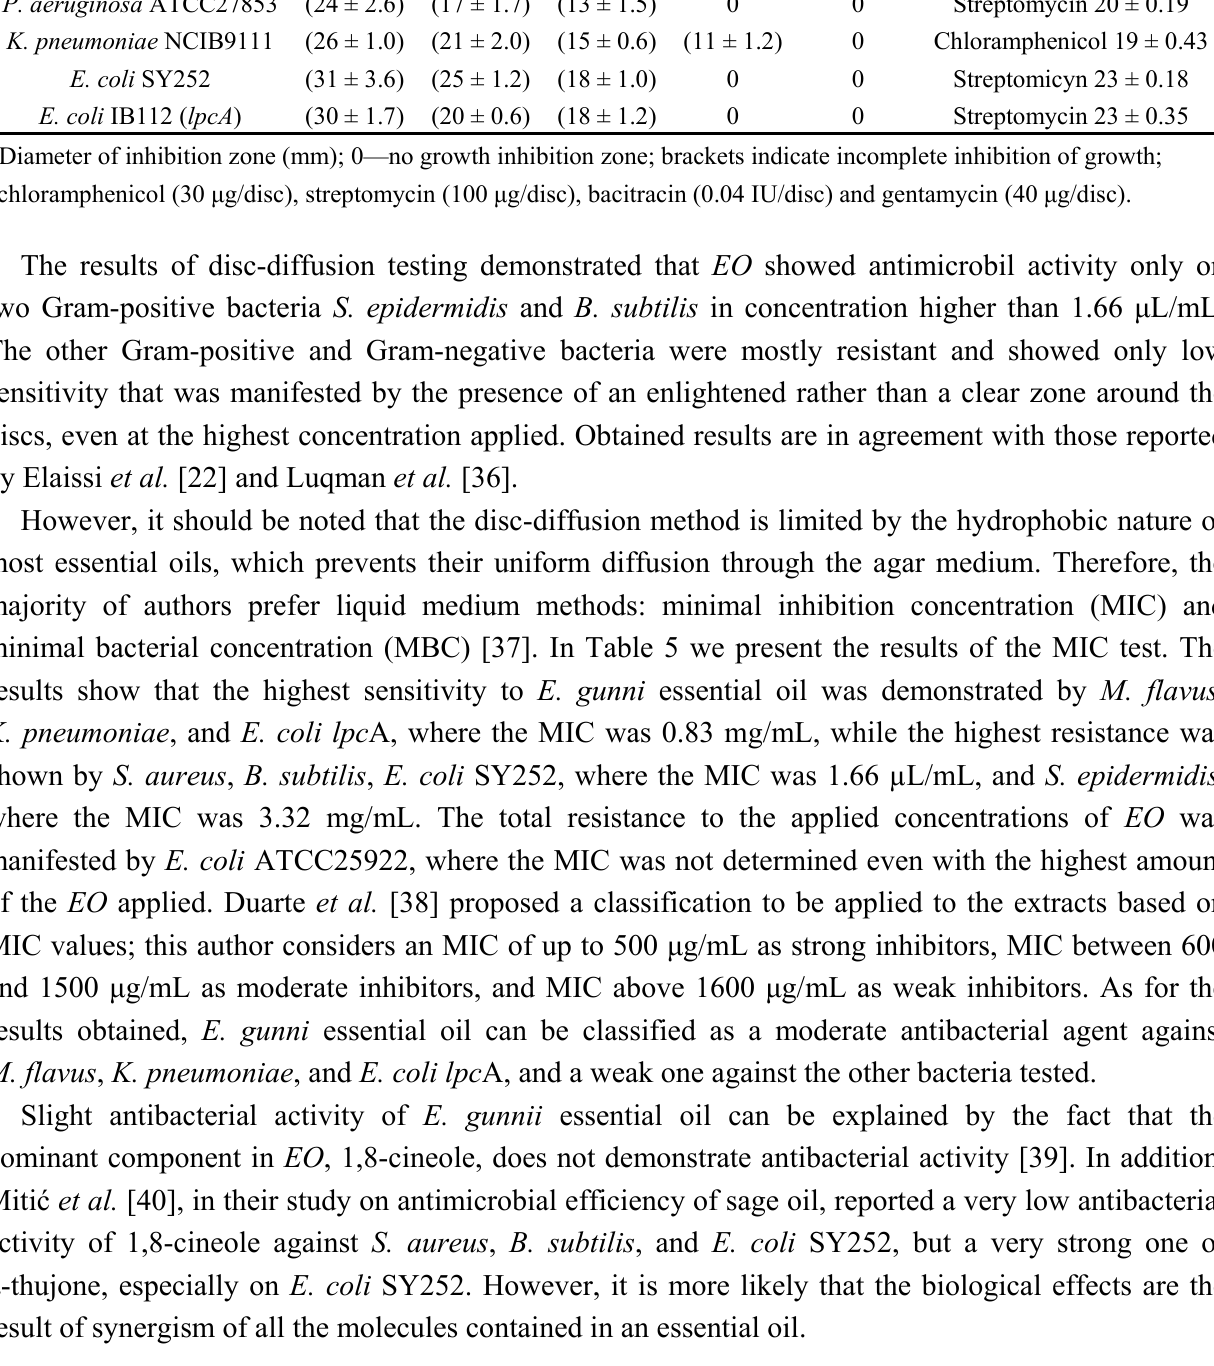
Table 4. Antibacterial activity of E. gunnii EO tested by disc-diffusion method. EO Concentrations (µL/disc) Bacterial Strains 3.32 1.66 0.83 S. epidermidis ATCC12228 S. aureus